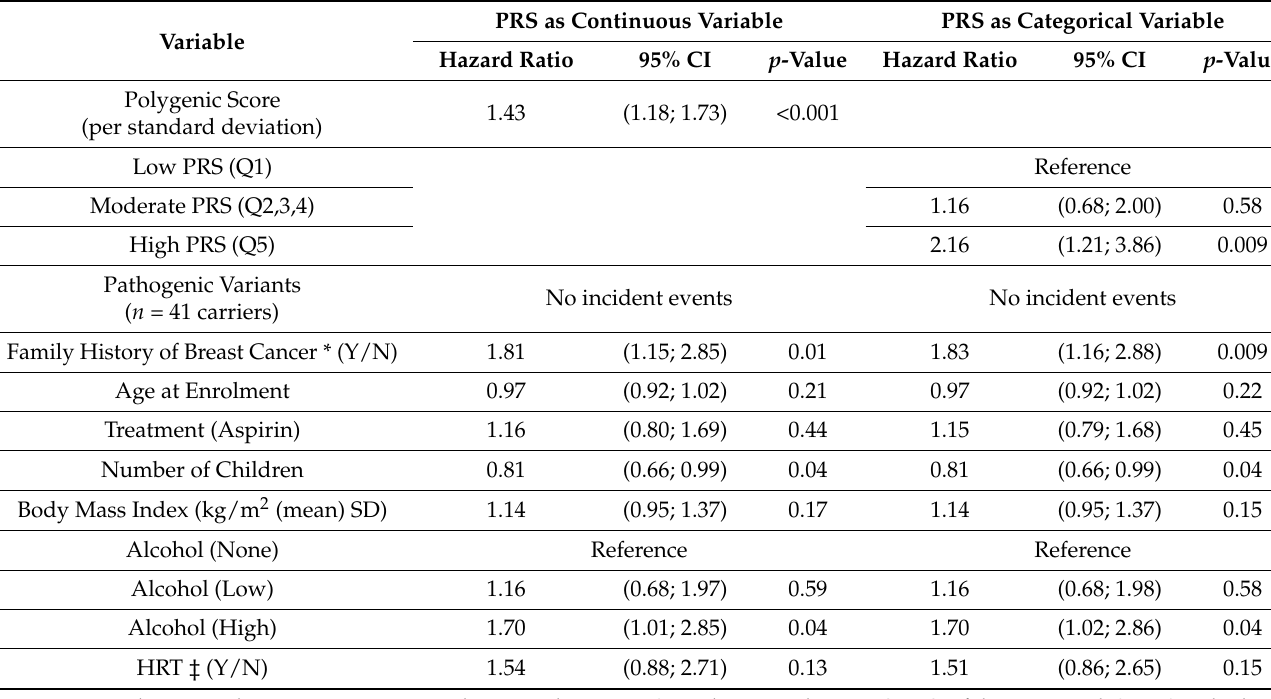
Table 2. Association of a polygenic risk score (PRS) with incident breast cancer (BC) risk in 6339 older women. A multivariable Cox proportional hazards regression model was used to evaluate the association between PRS as a continuous or categorical variable with incident BC ( n = 110 cases), after adjusting for family history of BC (first-degree blood relatives), treatment (aspirin/placebo), age at enrolment, number of children, alcohol use, BMI at enrolment and use of hormone replacement therapy (HRT) at